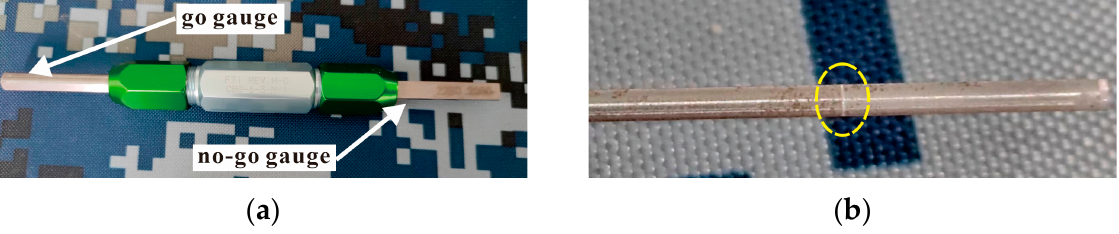
Figure 8. ( a ) FTI standard go/no-go gauge; ( b ) the no-go gauge bayonet.